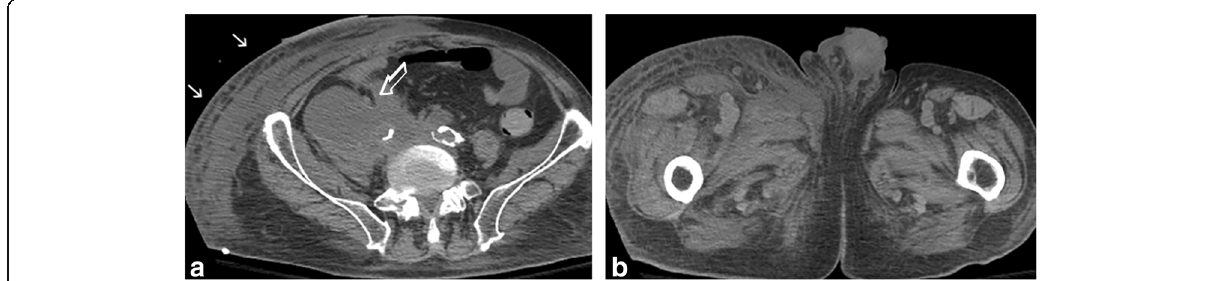
Fig. 1 Non-contrast CT images through ( a ) the lower pelvis and ( b ) upper thighs demonstrating a large obstructing right pelvic tumor (open arrow), significant right-sided subcutaneous edema (arrows), and marked limb asymmetry due to right limb